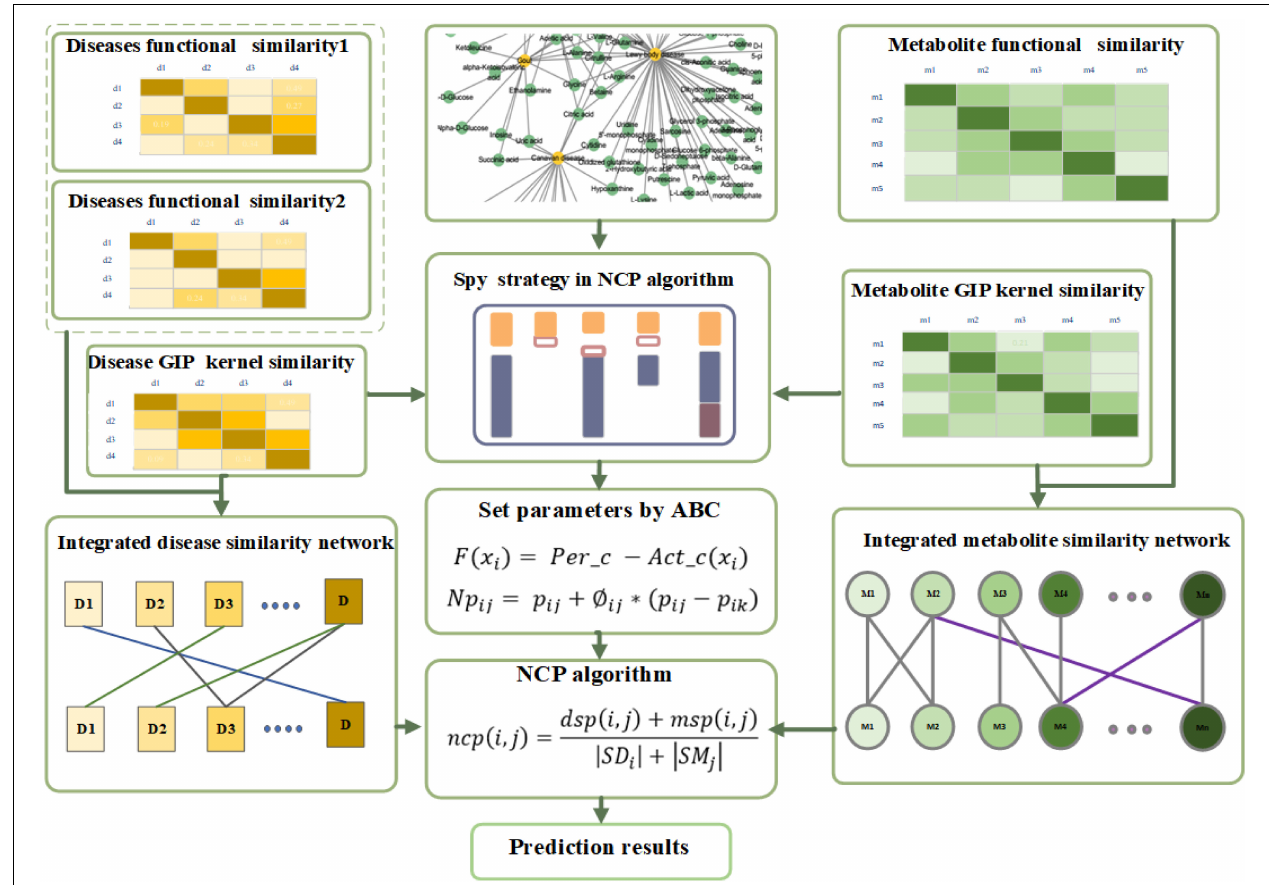
FIGURE 1 | Flowchart of